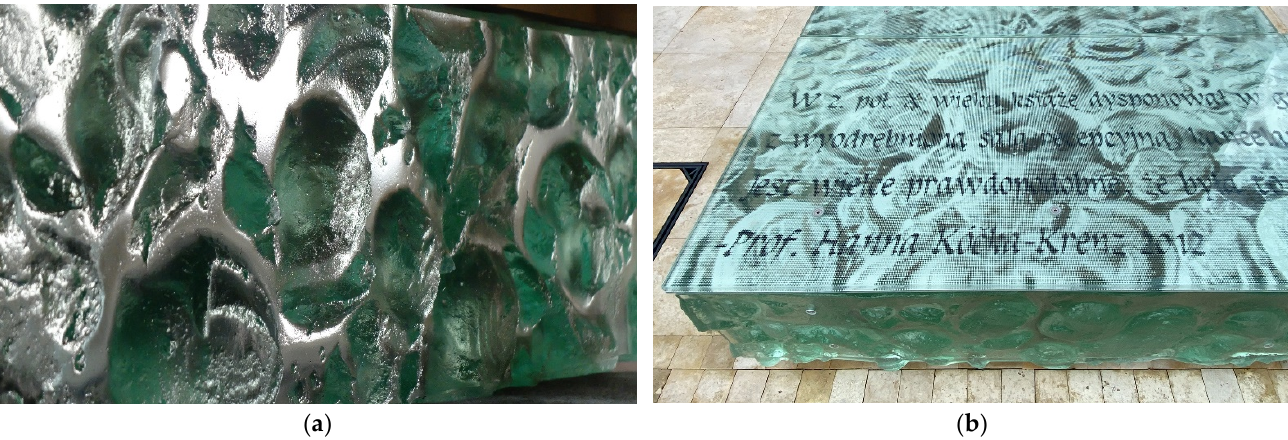
Figure 13. ( a ) Vertical relief kiln-formed cast glass; ( b ) horizontal UV screen-printed graphic on the bottom layer of the laminated glass (Konrad